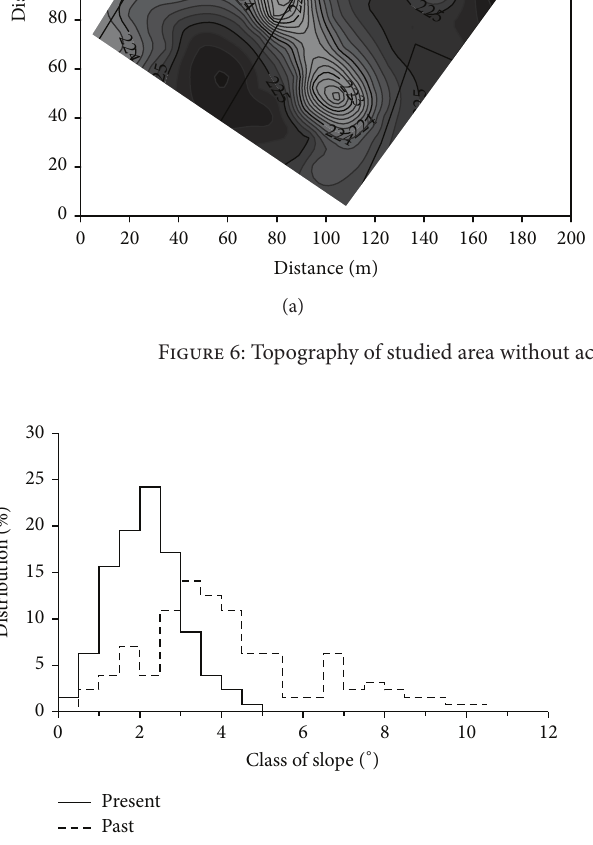
Figure 7: Distribution of slope classes in the present and past relief.